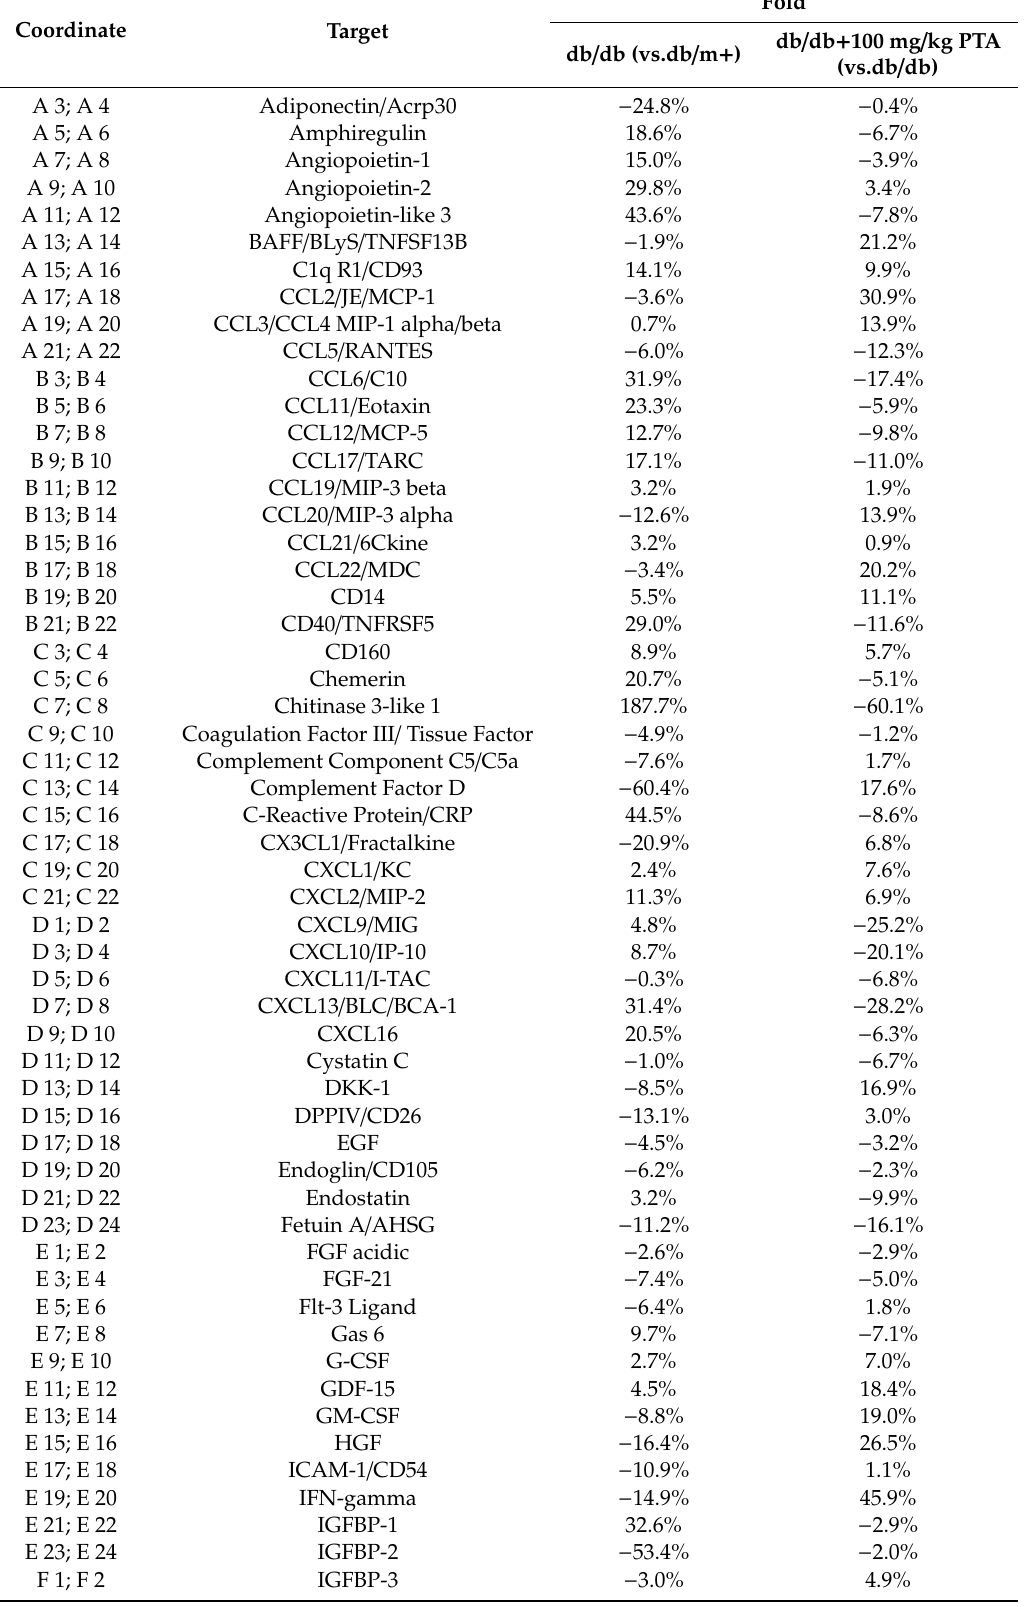
Table A2. All of the detailed parameters of target cytokines decreased or increased among experimental